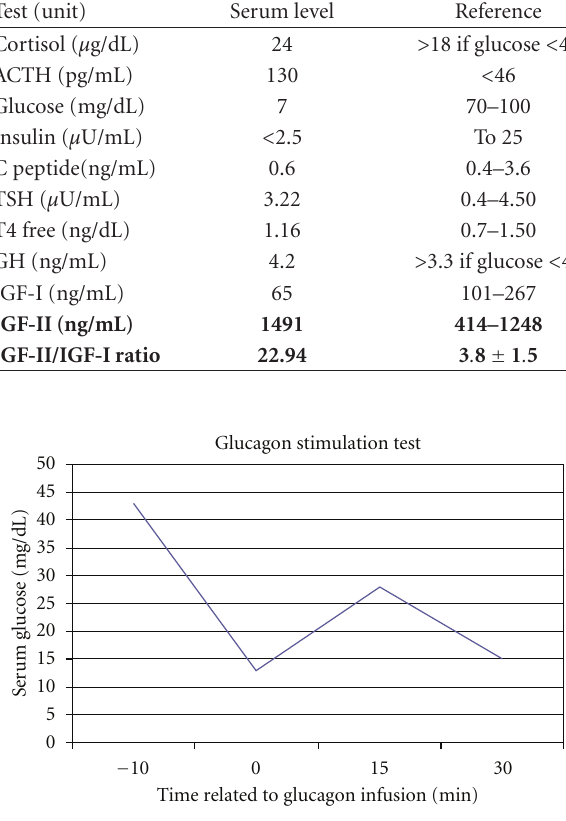
Figure 3: Partial response to glucagon stimulation